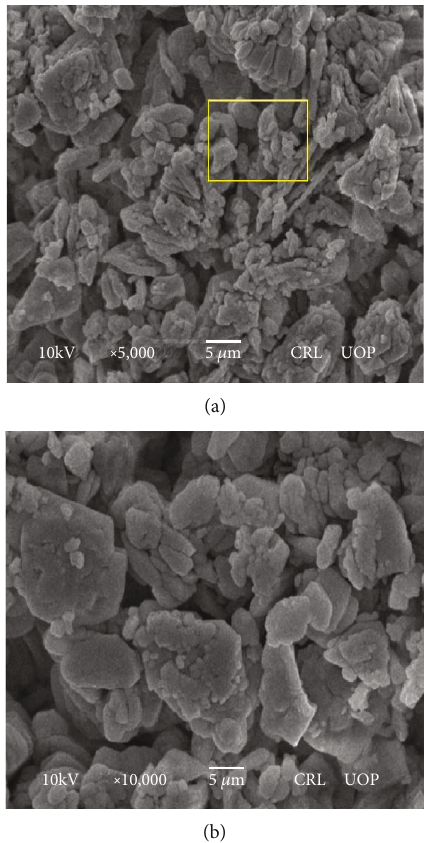
Figure 2: (a, b) SEM micrographs of CoF precipitation method with di ff erent magni fi cations.